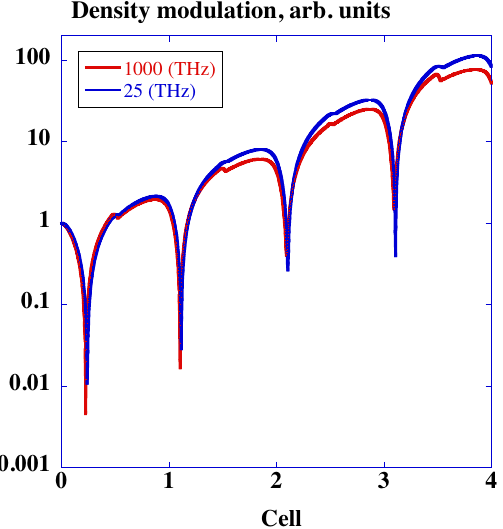
FIG. 6. Evolution of the amplitude of the density modulation amplitude in the four-cell PCI periodic lattice with parameters shown in Table I: blue line, case 1, gain ¼ 114 ; red line, case 2, gain ¼ 75